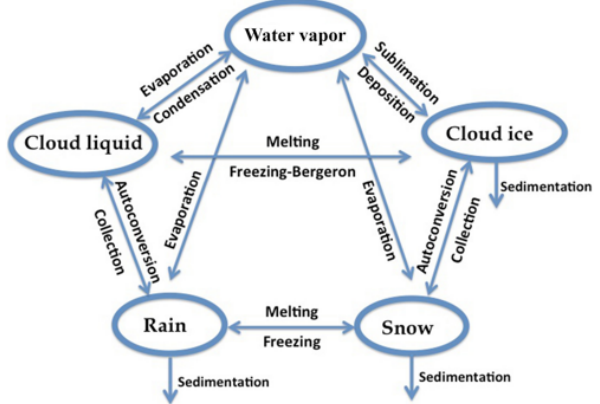
Figure 2. Depiction of the new scheme, showing the five prognostic variables and how they are related to each other through microphys- ical